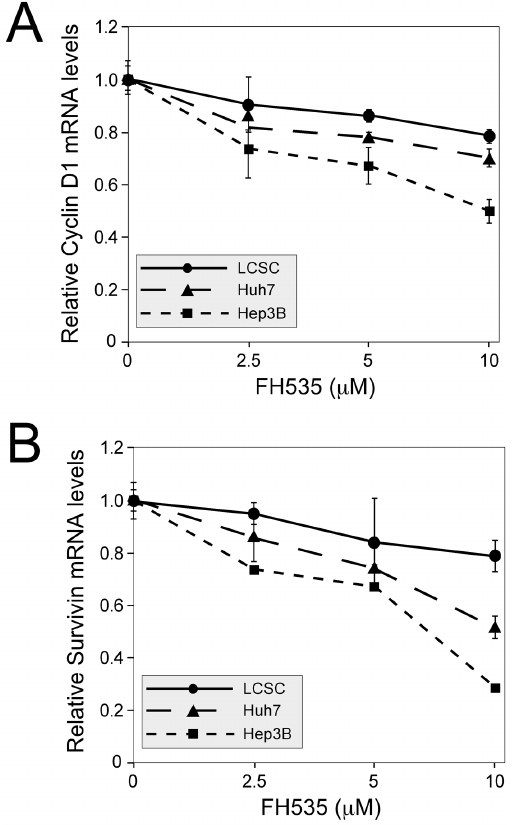
Figure 5. FH535 reduces cyclin D1 and survivin mRNA levels in LCSC and in HCC cell lines. LCSCs, Huh7 and Hep3B cells were treated with DMSO alone or increasing concentrations of FH535 for 38 hours prior to harvesting. RNA was analysed by real-time PCR for expression of Cyclin D1 (Panel A) or Survivin (Panel B). In both cases, mRNA levels were plotted relative to b 2 -microglobulin. The experiment was done twice with similar results.